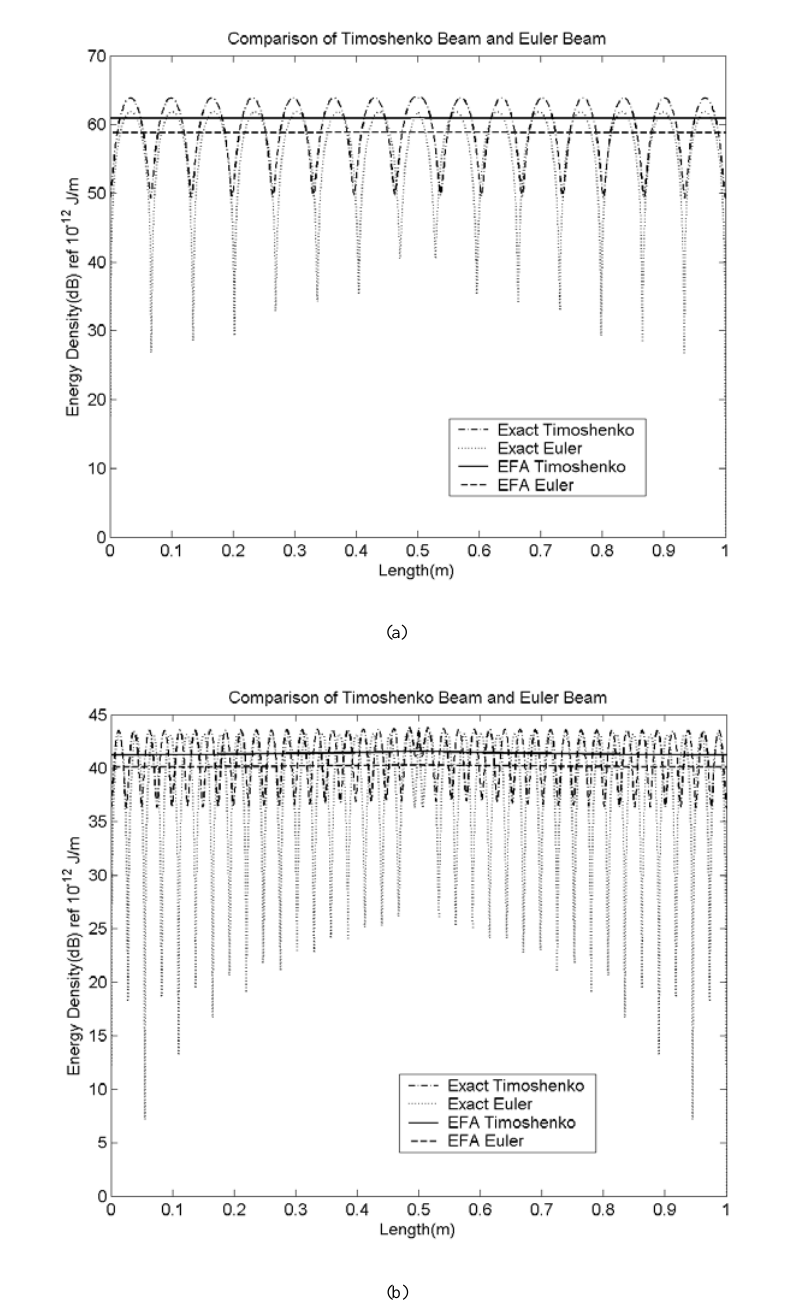
Fig. 6. The energy density level distributions of the Timoshenko beam ( L / H = 100, f c = 159 kHz) when η = 0.01. The reference energy density is 10 − 12 J/m: (a) f = 5 kHz, (b) f = 30 kHz (c) f = 150 kHz, (d) f = 200 kHz: - · - · -, classical solution of the Timoshenko beam; ····· , classical solution of the Euler-Bernoulli beam, —, EFA solution of the Timoshenko beam; ---, EFA solution of the Euler-Bernoulli